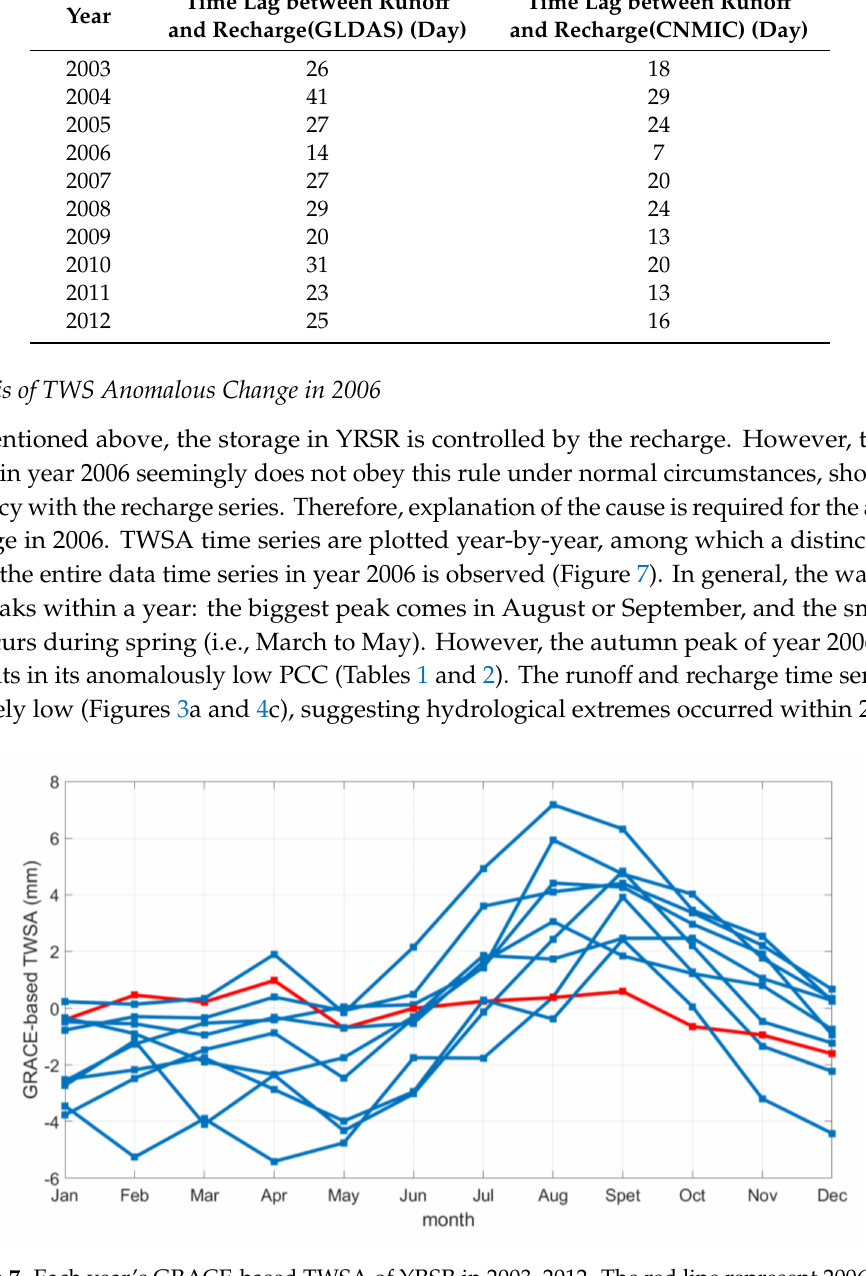
Figure 7. Each year’s GRACE-based TWSA of YRSR in 2003–2012. The red line represent 2006